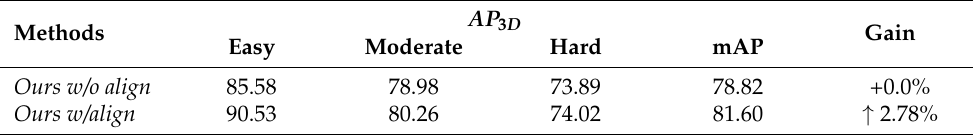
Table 6. The ablation study of neighbors feature alignment mechanism on car category